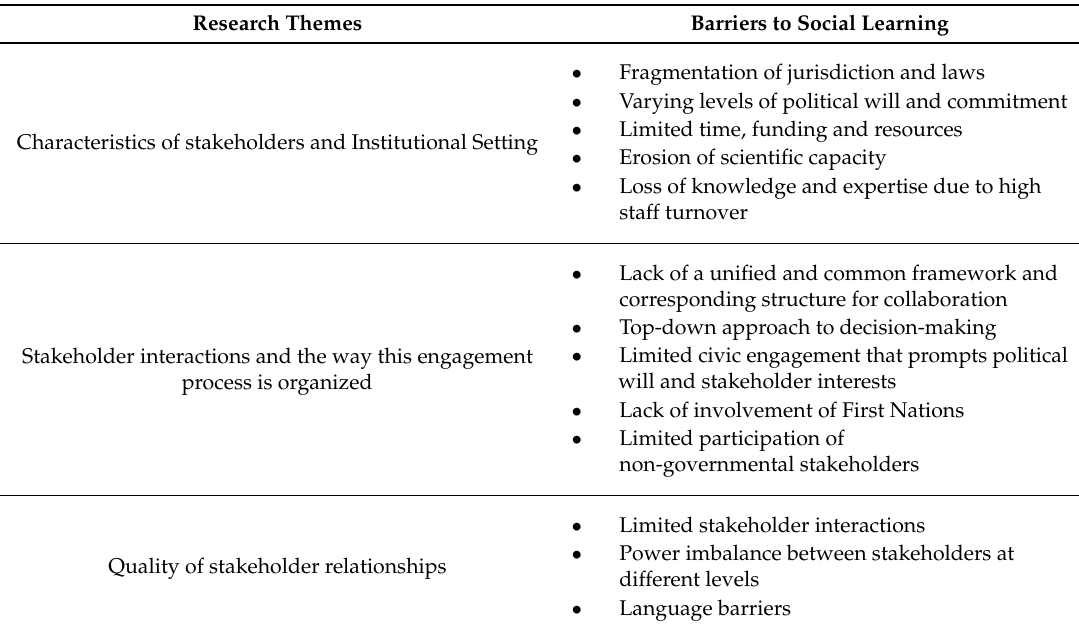
Table 4. Summary of barriers to social learning for transboundary water